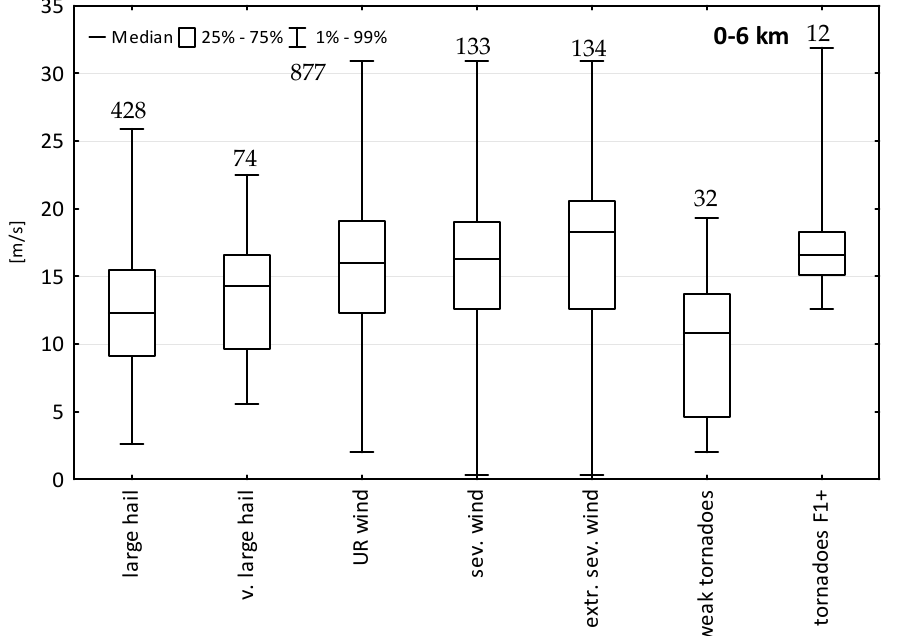
Figure 5. As in Figure 2, except for the 0–6 bulk wind shear.